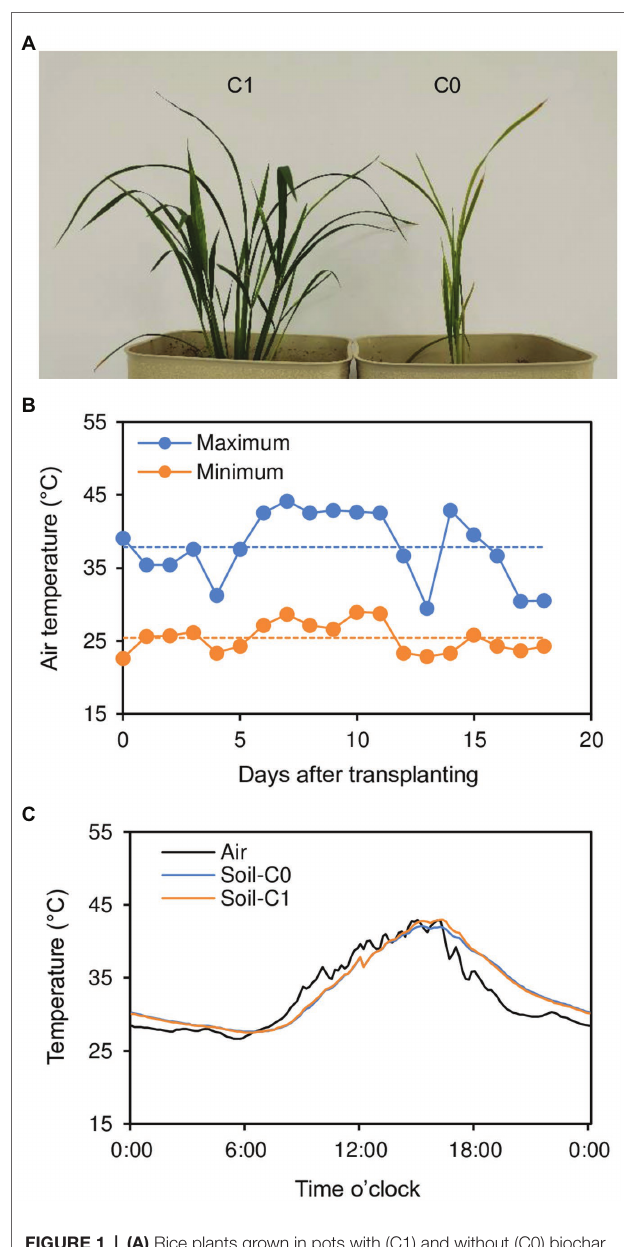
FIGURE 1 | (A) Rice plants grown in pots with (C1) and without (C0) biochar application shown at 18 days after transplanting, (B) daily maximum and minimum air temperatures around rice plants during the experimental period, and (C) air and soil temperatures for the 24 h on day 9 after